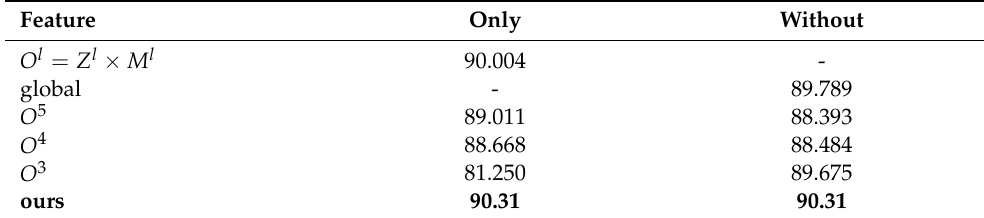
Table 2. Comparison of different configurations of our model on FI dataset, including “only” and ”without”. For example, “only” of 𝑂 5 refers to the final sentimental feature 𝐸 = 𝑂 5 , “without” means that 𝐸 is the concatenation of 𝑂 4 , 𝑂 3 , 𝑋 5 ,without 𝑂 5 . The bold score is the highest score of each column.